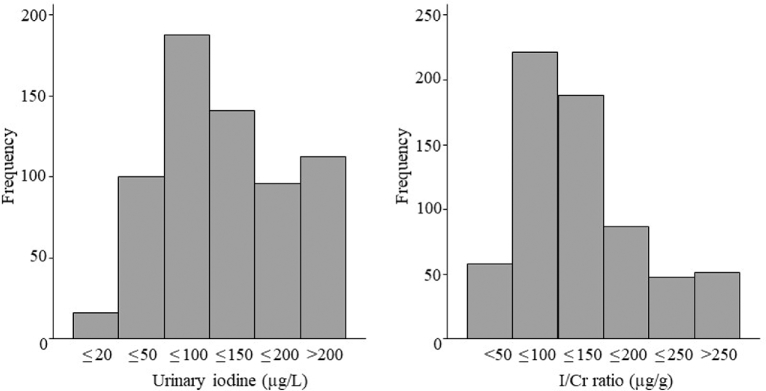
Frequency distributions of preconception urinary iodine concentration and I/Cr ratio, determined in spot samples from 654 women in the Southampton Women's Survey. I/Cr, iodine:creatinine.